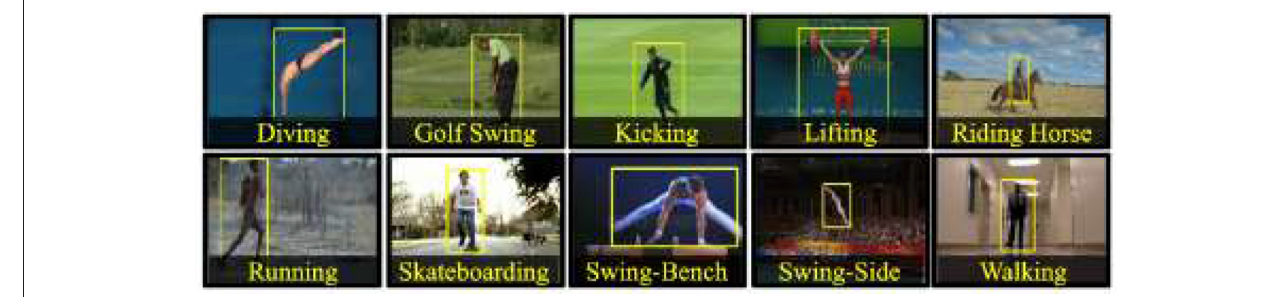
FIGURE 11 | UCF Sports datasets.